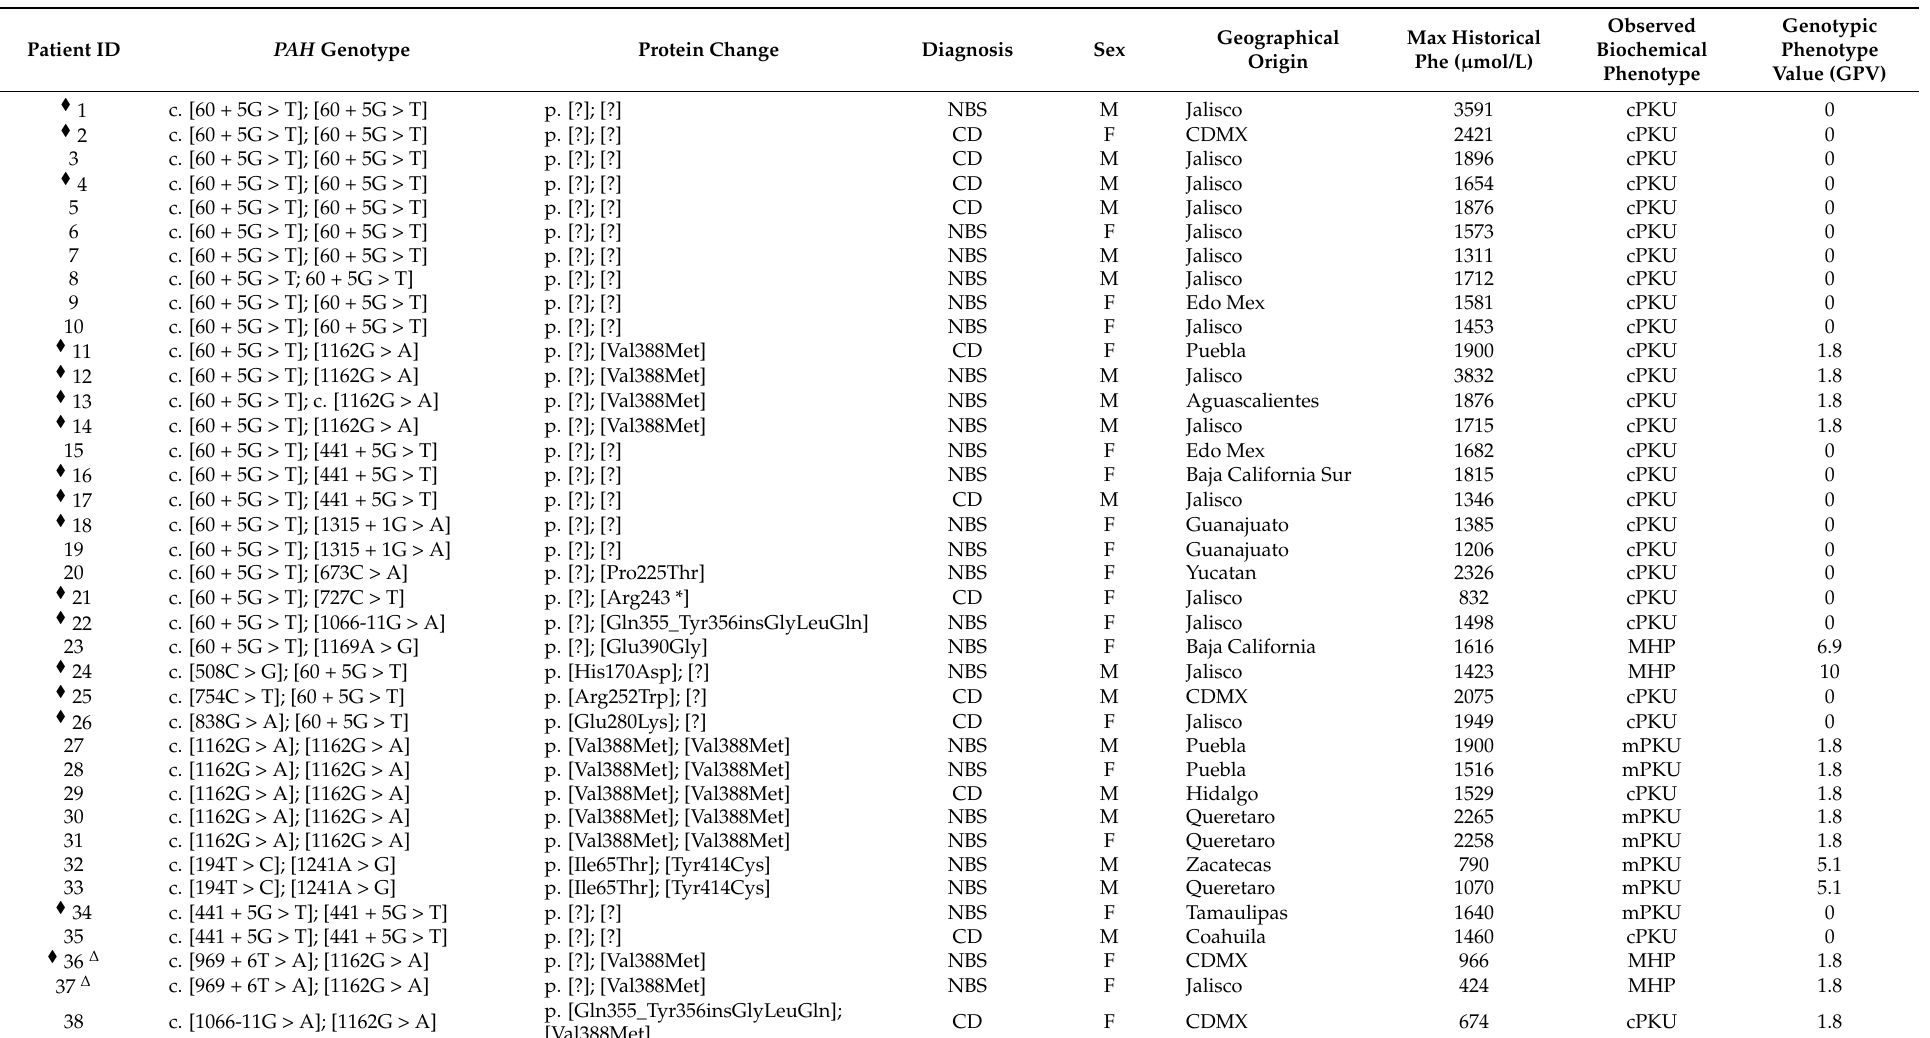
Table 2. Genetic spectrum, demographic, clinical, and biochemical characteristics of the studied Mexican HPA/PKU patients ( N =